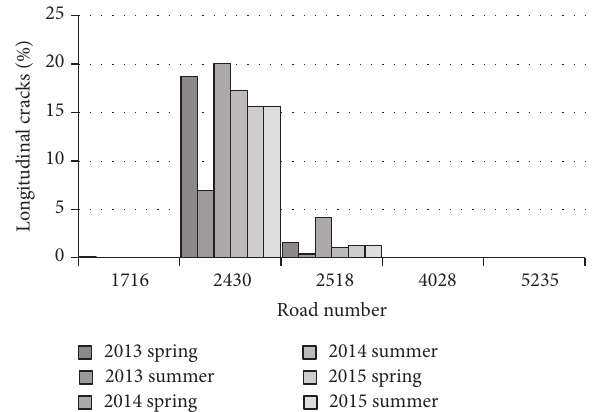
Figure 6: Longitudinal cracks on roads sections covered with soft asphalt.